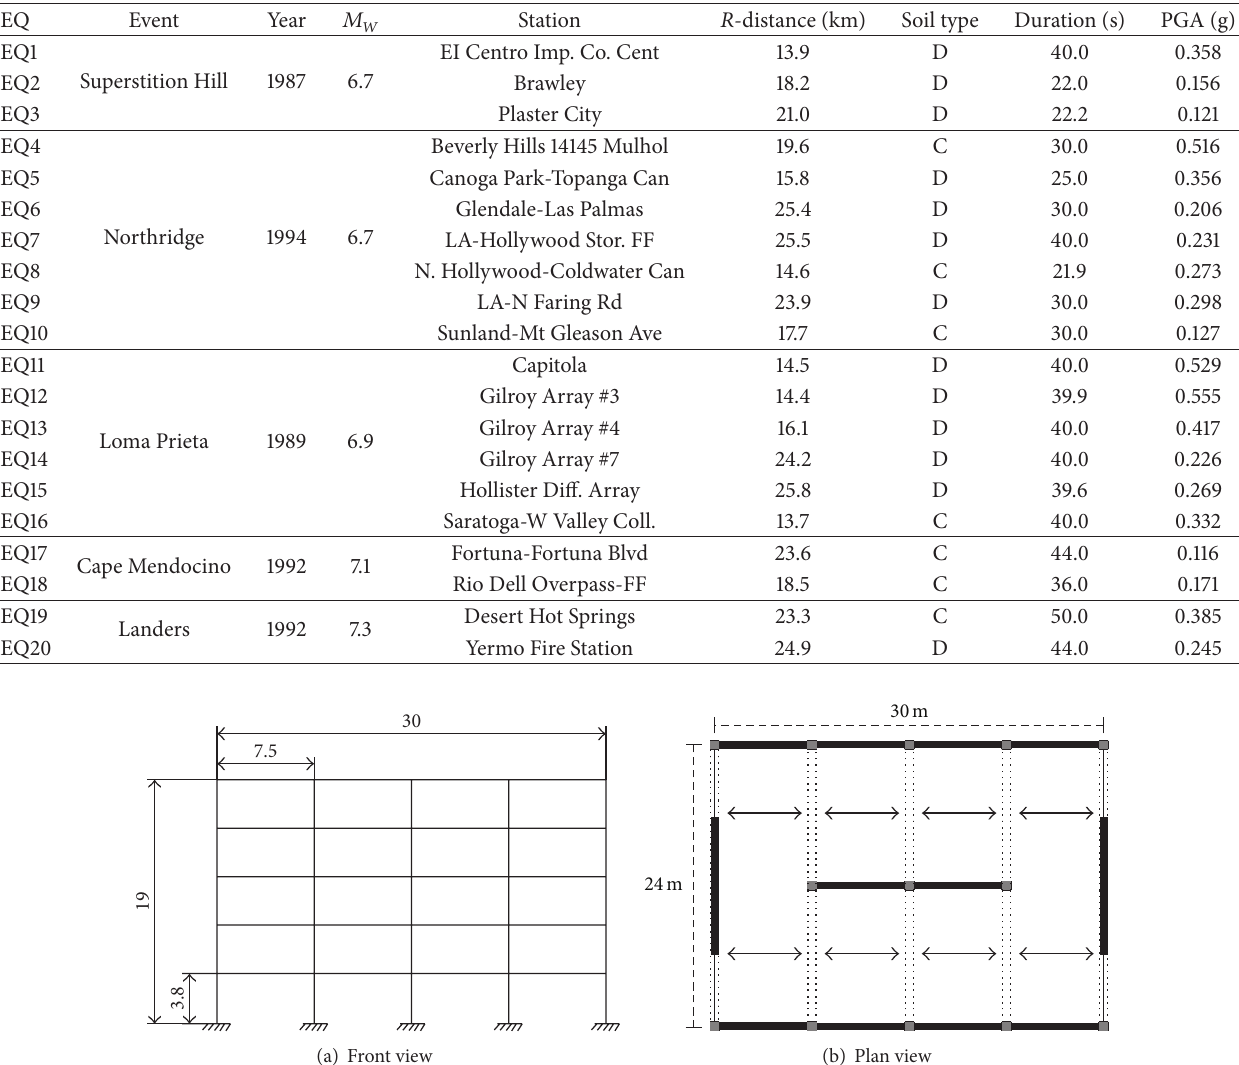
Table 1: Selected 20 ground motions.